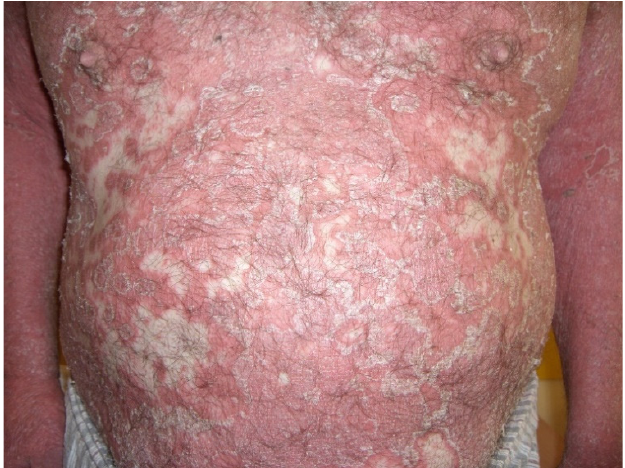
Figure 4. Erythrodermic psoriasis: widespread, confluent erythema with marked scaling and exfo- liation on the trunk as well as the upper limbs.